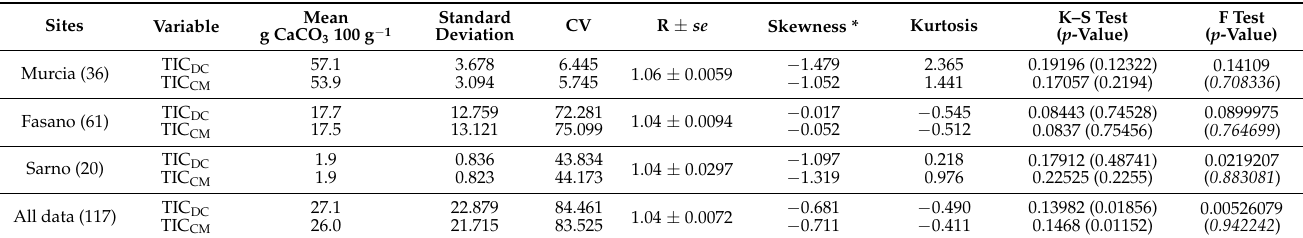
Table 3. Descriptive statistics of soil inorganic carbon quantified through volumetric calcimeter (TIC CM ) and dry combustion (TIC DC ) methods per experimental site and on the whole data set (n = 117).